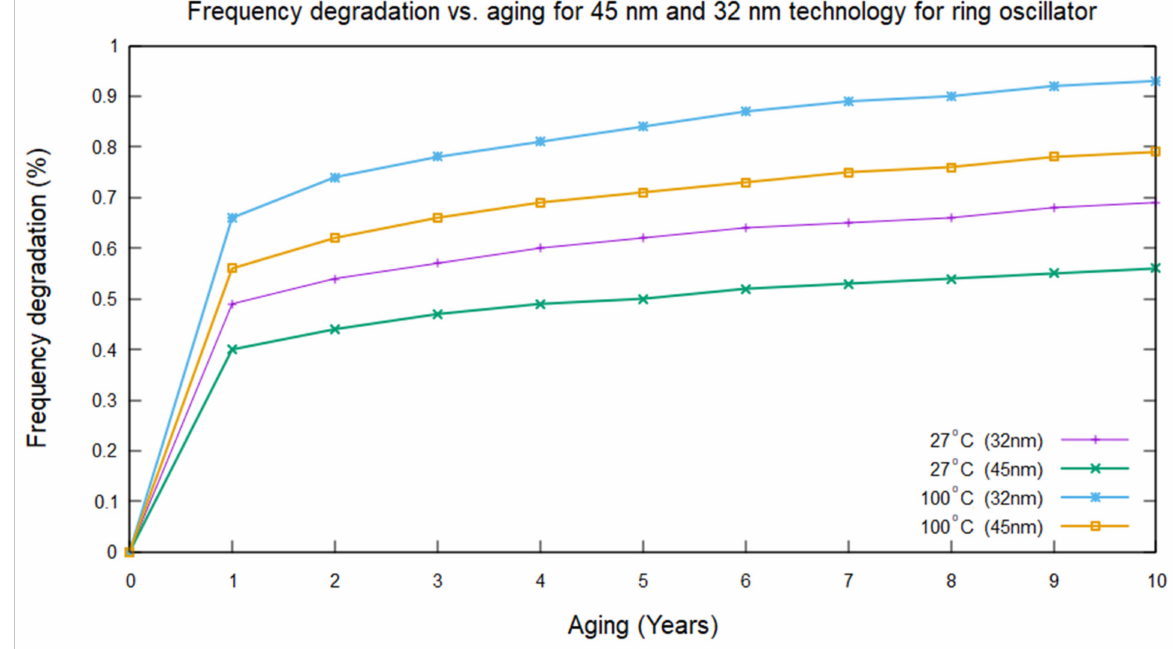
Figure 2. Frequency degradation versus aging for 45 nm and 32 nm technology ring oscillators at 27 ◦ C and 100 ◦ C caused by HCI and NBTI,